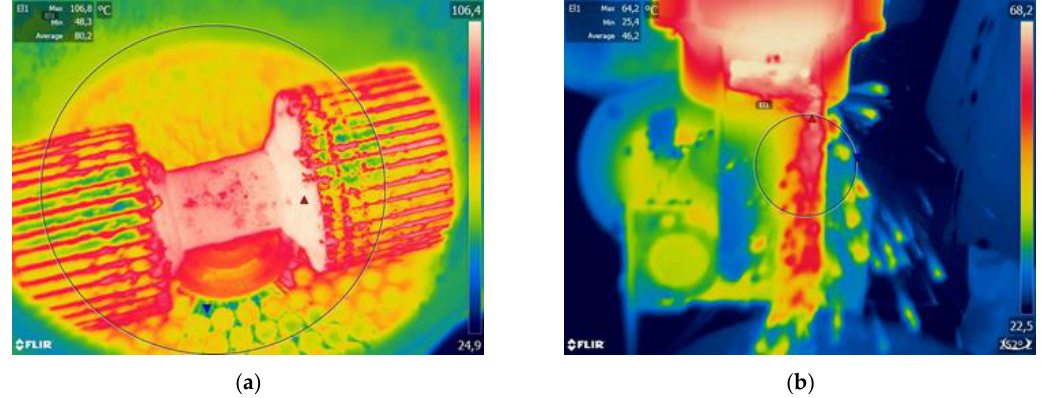
Figure 14. Thermographs from the infrared (IR) camera using the biomass die: ( a ) view of die and rollers, and ( b ) view of pellet output.